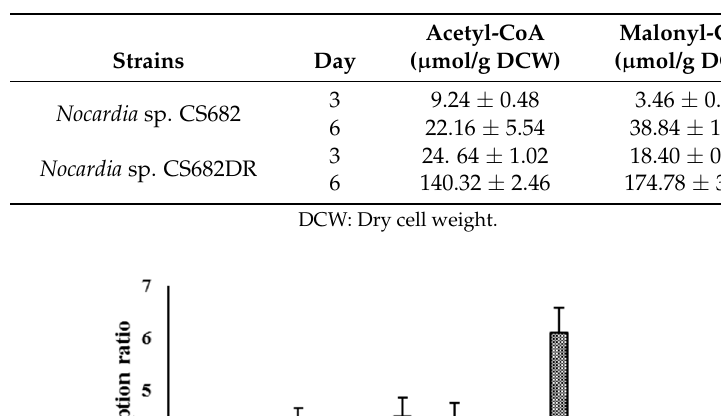
Table 4. Analysis of acyl-CoA extracted from Nocardia sp. CS682 and Nocardia sp. CS682DR.